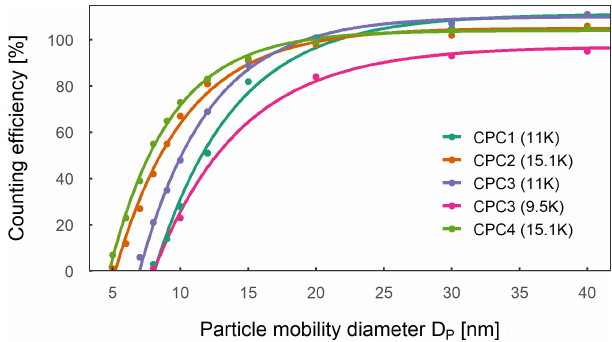
Figure 2. Regression curves of counting efficiency of four modified CPC 3007 for different Peltier voltage settings, with resulting tem- perature differences between saturator and condenser in